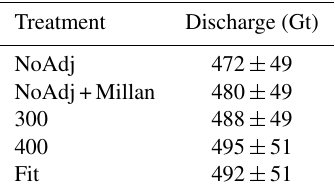
Table A2. Effect of different thickness adjustments on baseline dis-